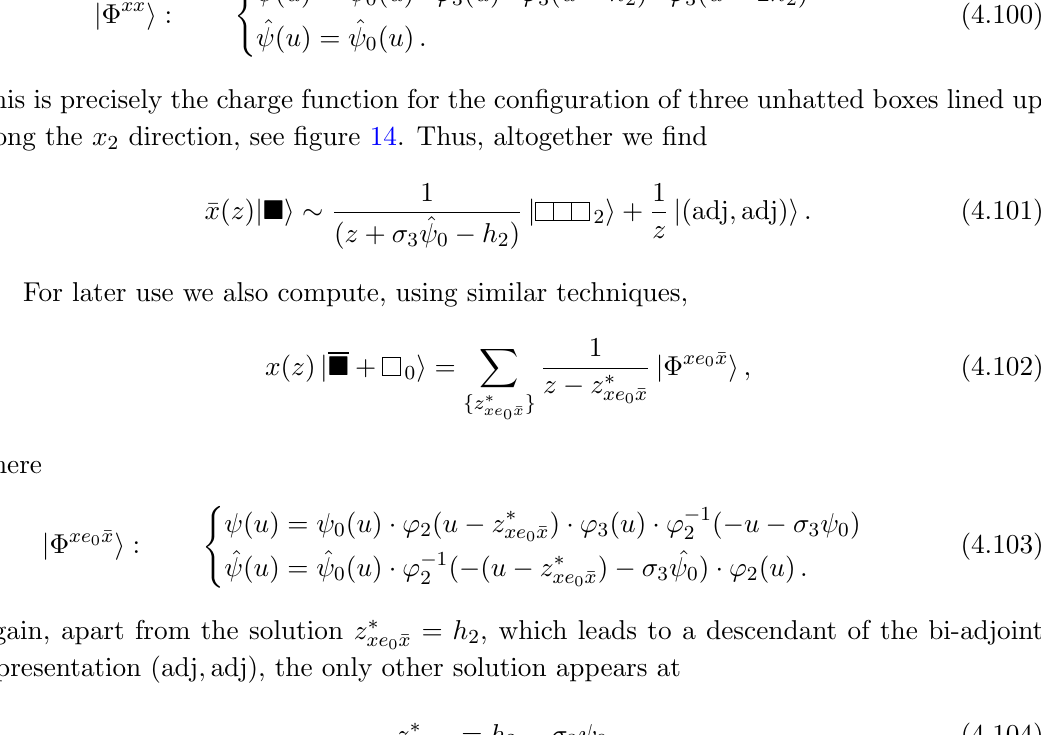
(cid:4) , see eq. (4.101). j i